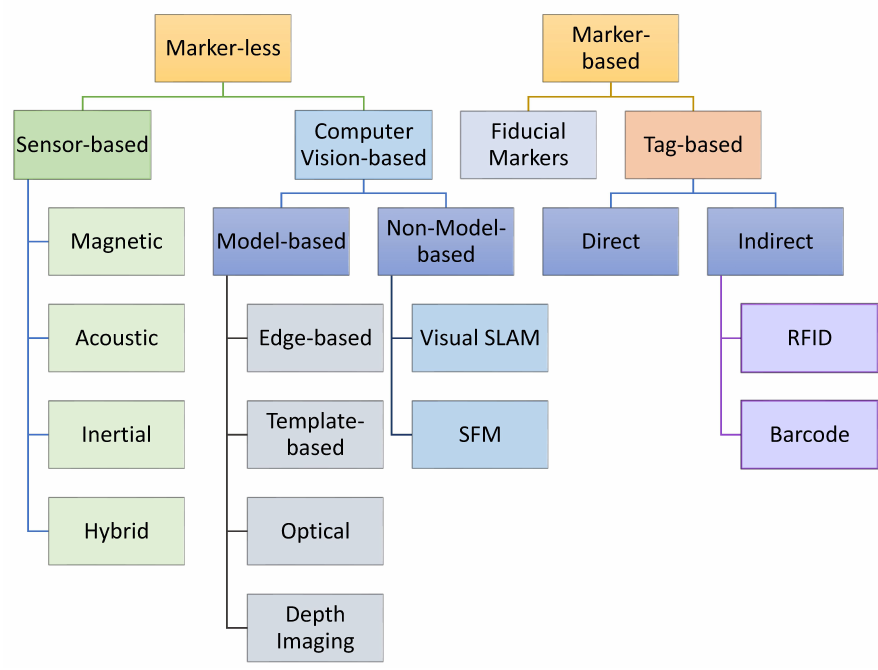
Figure 4. Categorization of augmented reality tracking techniques.